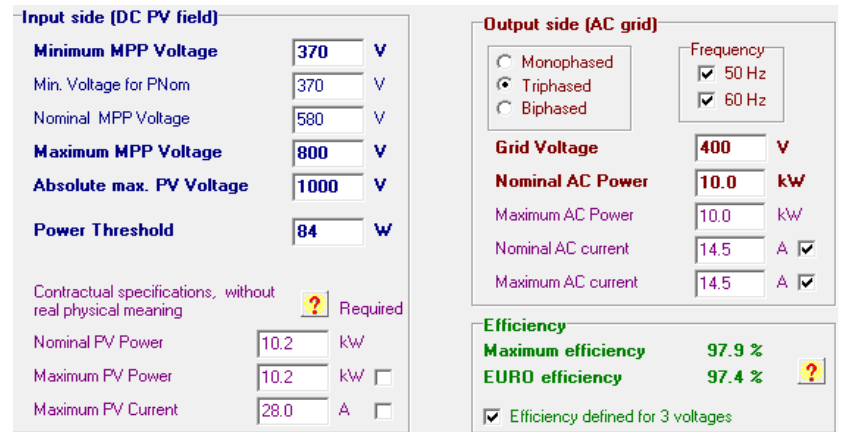
Figure 7. Grid-connected inverter specifications.